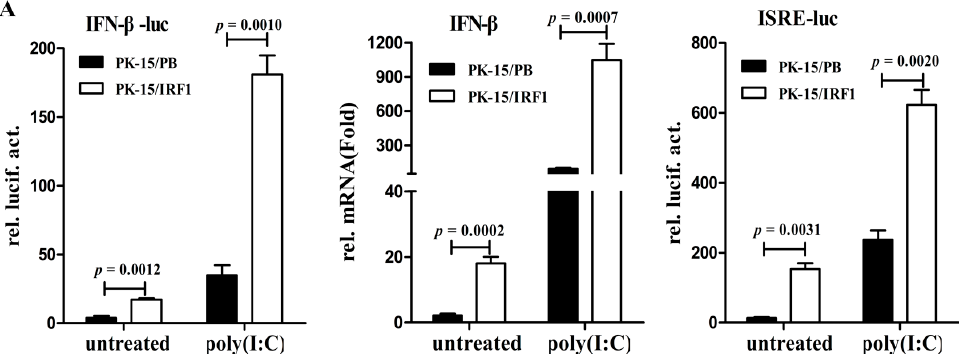
Figure 4. Cont. Figure 4. Cont .